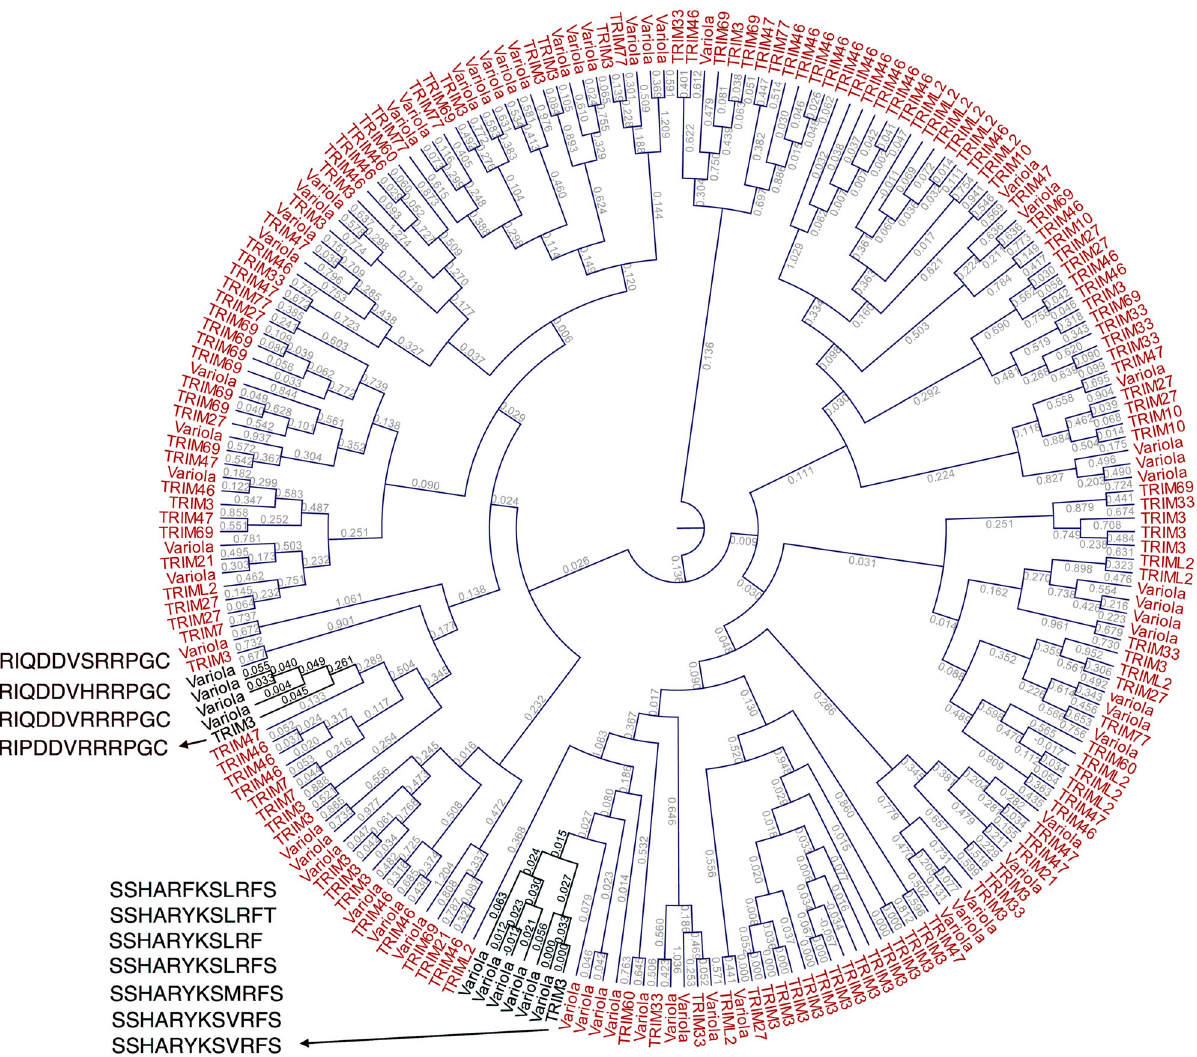
Fig. 6 Circular cladogram of phylogenetic distances between Variola virus and TRIM epitopes identi fi ed in dermatomyositis. The DM-speci fi c epitope sequences identi fi ed in TRIM3 and Variola virus had the highest similarity and are annotated next to the cladogram clades. Branch lengths represent the phylogenetic distance (Kimura protein